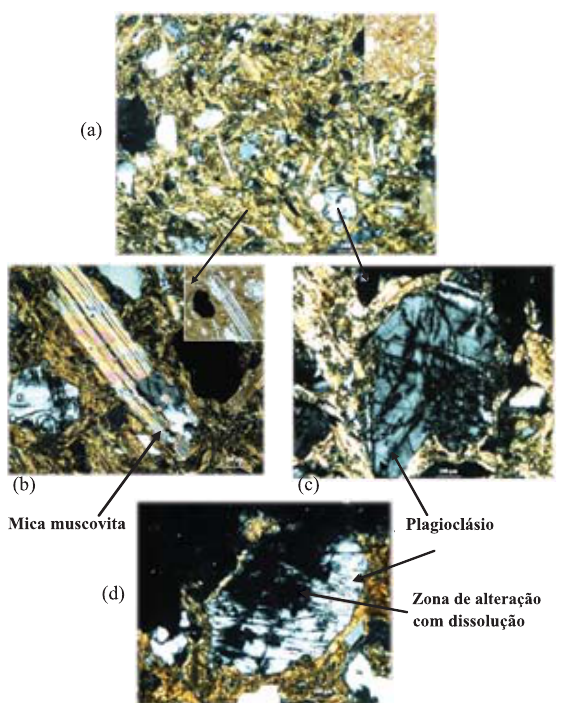
Figura 4. Fotomicrografias (XPL) do horizonte Bi1 do perfil P1, com detalhes sob luz PPL: (a) fundo matricial recoberto por mica, principalmente muscovita, com trama porfírica fechada; (b) aumento do fundo matricial, com mica e feldspatos potássicos aprisionados no plasma; (c) plagioclásio cálcio-sódico com áreas de alteração; (d) estádio mais avançado de alteração do plagioclásio.